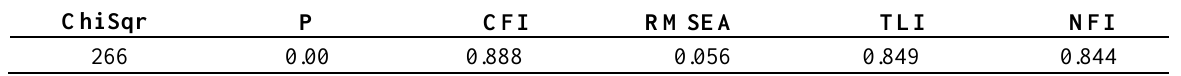
Table.4. Model fit-indices for MSLQ on the local